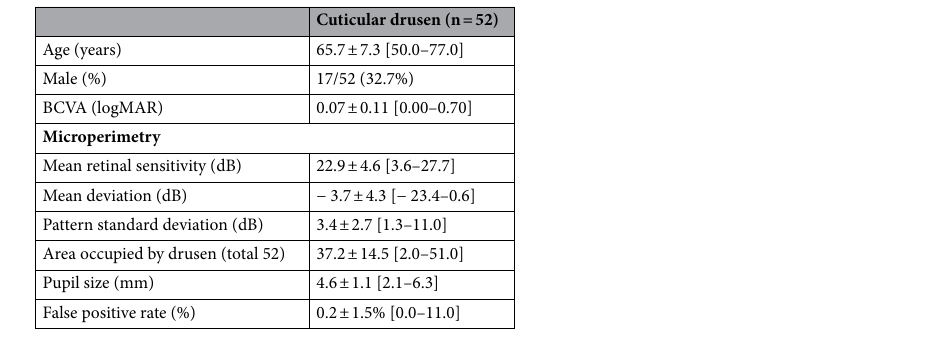
Table 1. Clinical features in eyes with cuticular drusen. Data are total no. (%) or mean ± standard deviation, unless otherwise indicated. BCVA Best corrected visual acuity, logMAR logarithm of the minimum angle of resolution, dB